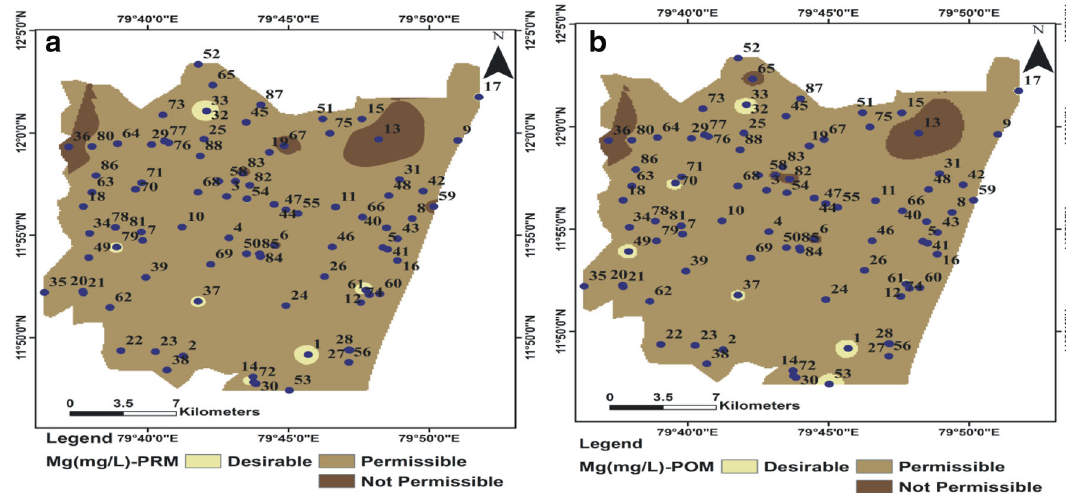
Fig. 9 a , b Spatial distribution map of Mg (pre- and post-monsoon)